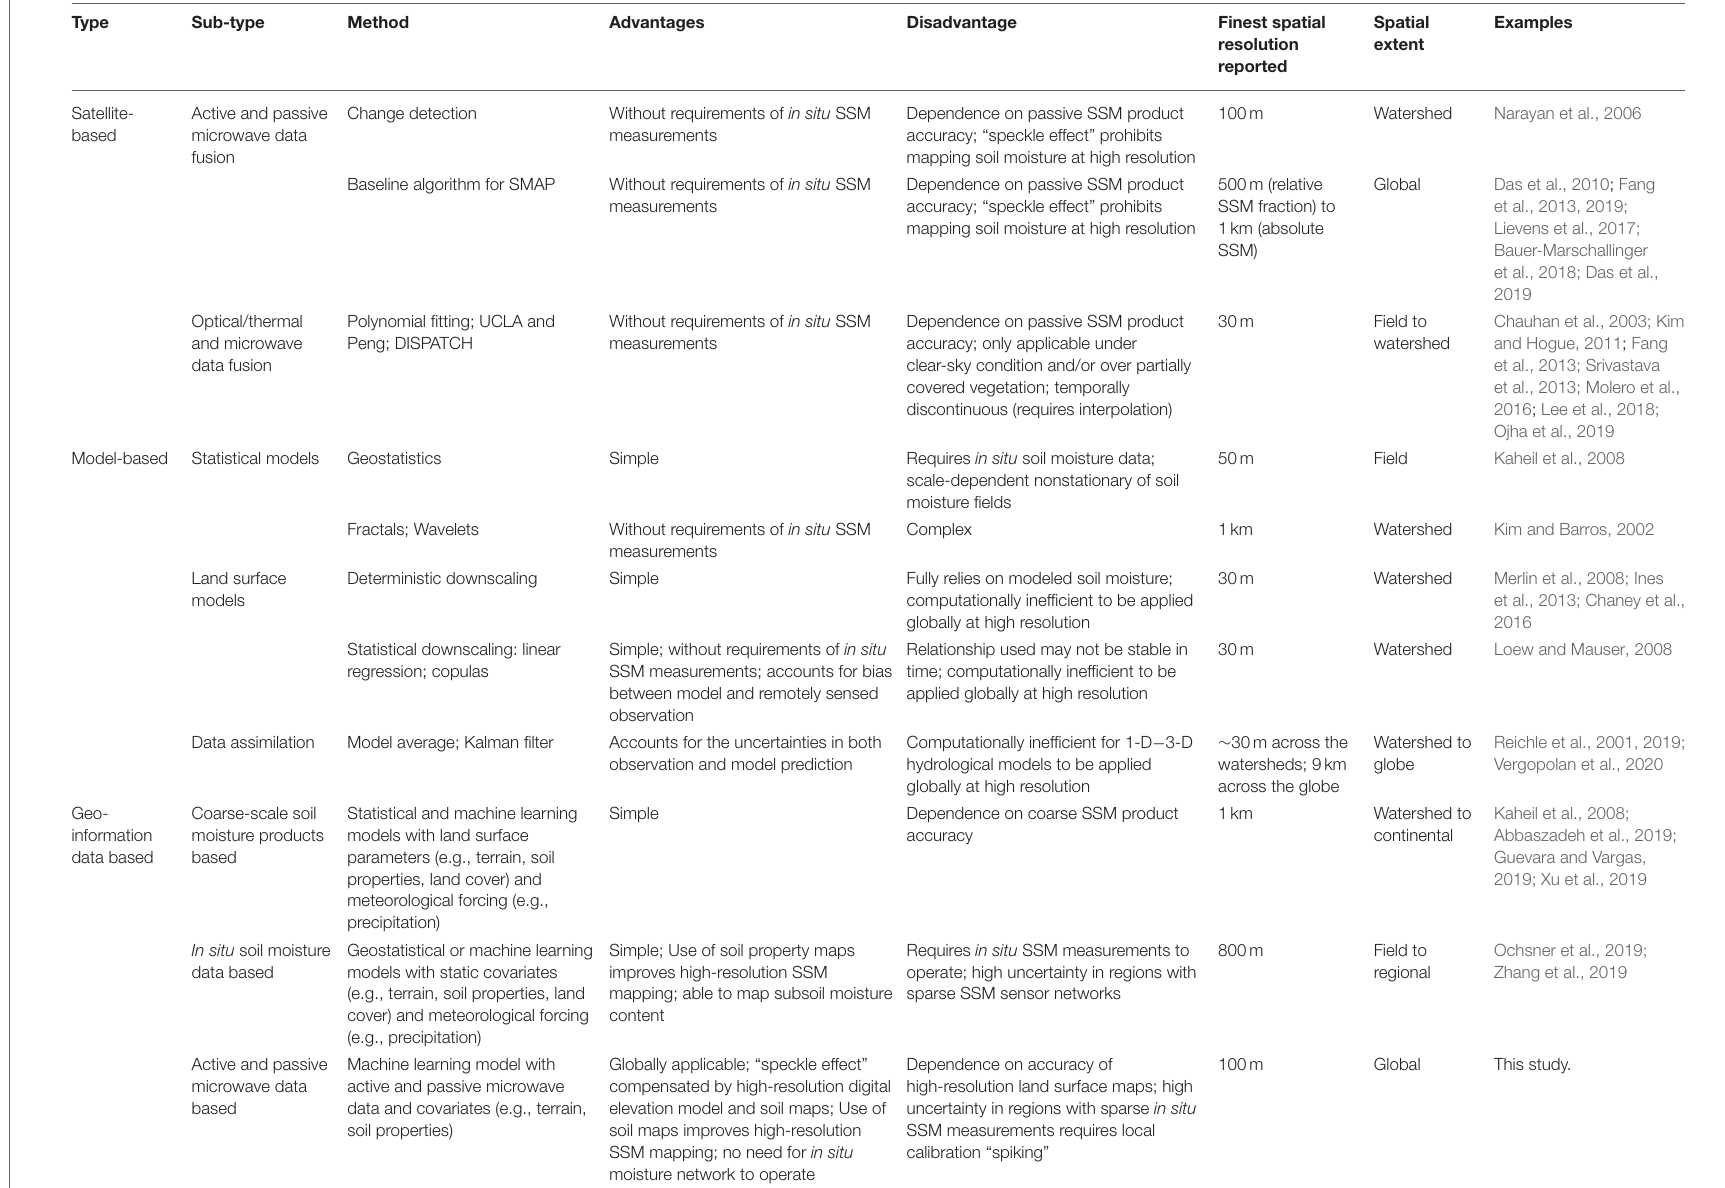
TABLE 1 | A brief summary of spatial downscaling methods for surface soil moisture—SSM (modified from Peng et al.,